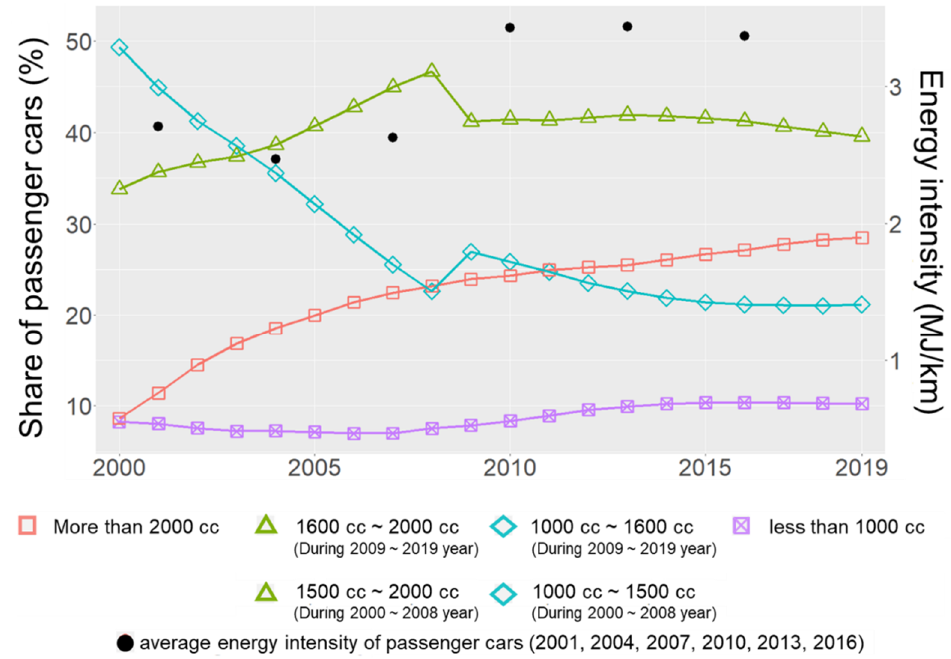
Figure 2. Share of passenger cars by engine size and weighted average energy intensity (EI) (source: Ministry of Land, Infrastructure and Transport [11], Korea Transport Institute [12], Korea Energy Economics Institute [13]). Note: MOLIT [11] changed the statistical classification of passenger cars in 2009.